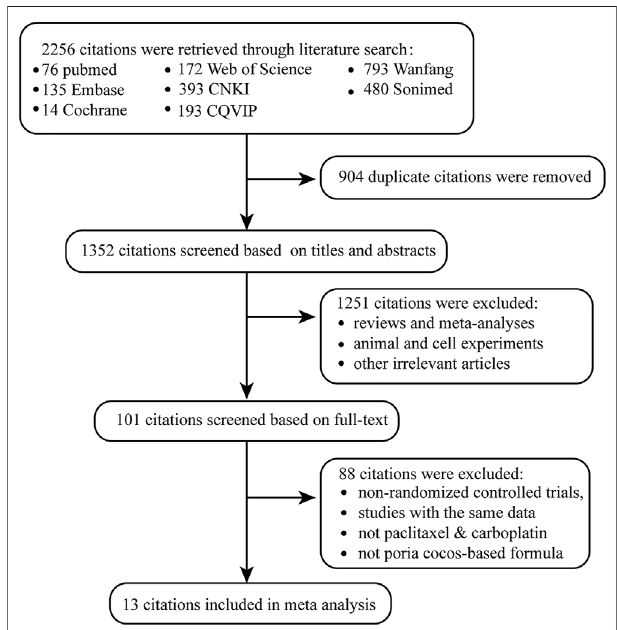
FIGURE 1 | Flow diagram for selecting eligible studies.